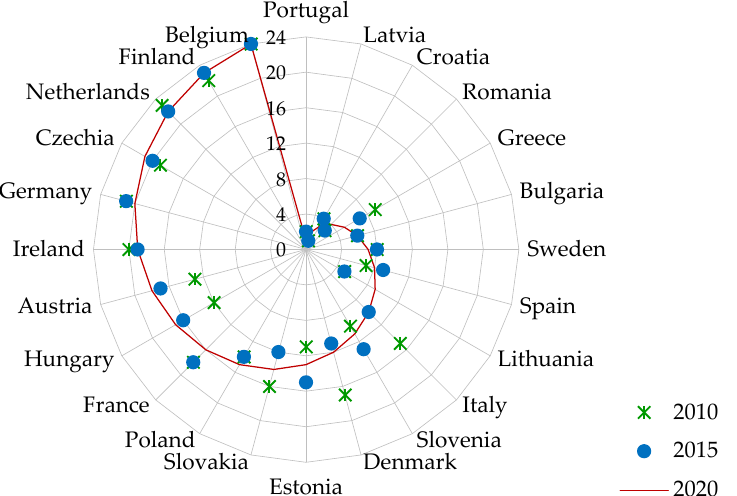
Figure 5. Ranks of EU states regarding sustainable energy consumption indicator ( Q , determined by the Formula (3)) in specific years.